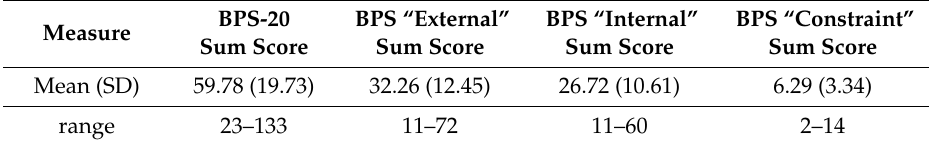
Table 3. Descriptive statistics of the BPS-20 and its subscales according to the exploratory factor analysis for the whole sample of N = 273 participants.